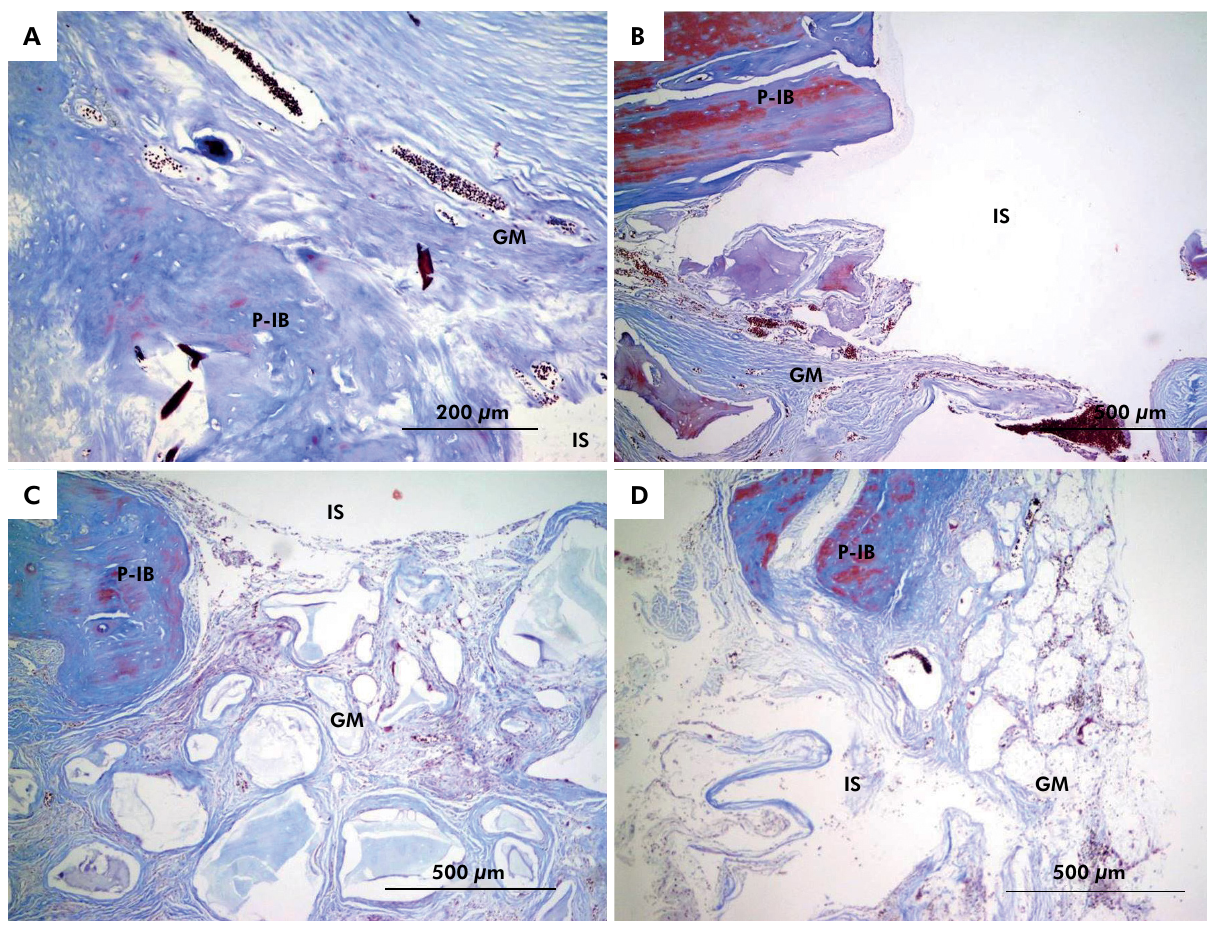
Figure 2. Histological images of a) calcium sulfate, b) deproteinized bovine, c) human-derived allogenic, and d) hydroxyapatite bone grafts. Masson’s trichrome